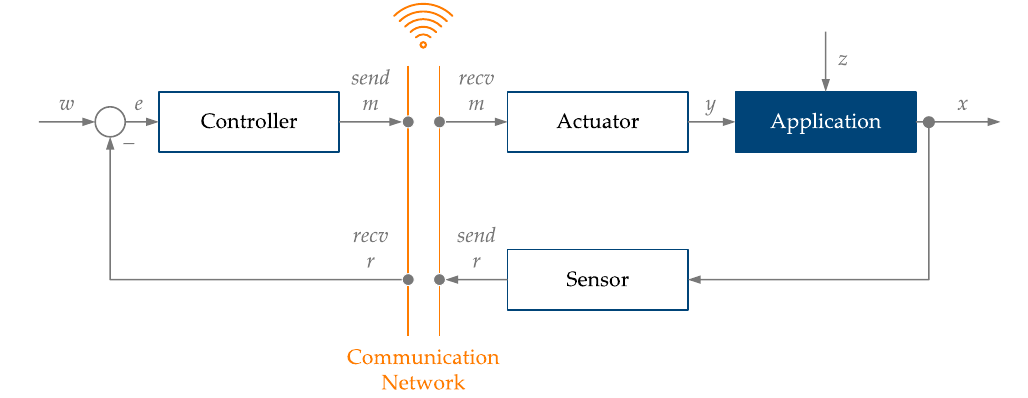
Figure 2. Architecture of a networked control system.